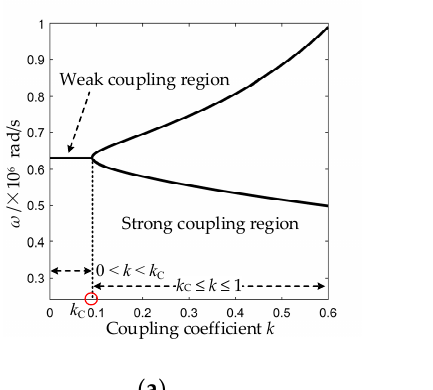
Figure 2. Curve of the relationship between system transmission characteristics and coupling coefficient k : ( a ) operating angular frequency ω ; ( b ) output power and transfer efficiency. (The system parameters are: the effective value of input voltage V in = 50 V, the natural resonance frequency f 0 = 100 kHz, the internal resistance r T = r R = 0.5 Ω, and the load resistance R L = 10 Ω).